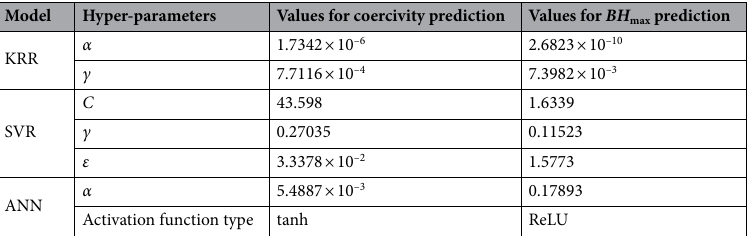
Table 1. Hyper-parameter values obtained by VFSA for three ML models for the prediction for both coercivity and BH max